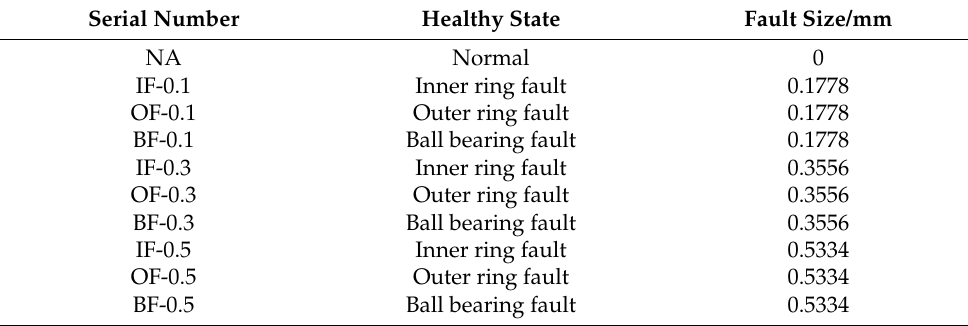
Table 1. Details of the CWRU dataset.